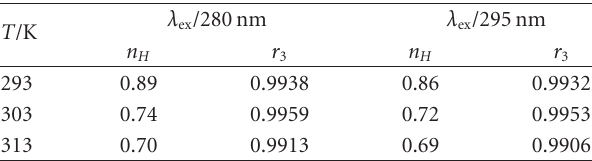
Table 2: Hill’s coe ffi cients n H of BSA-Avelox at di ff erent tempera-